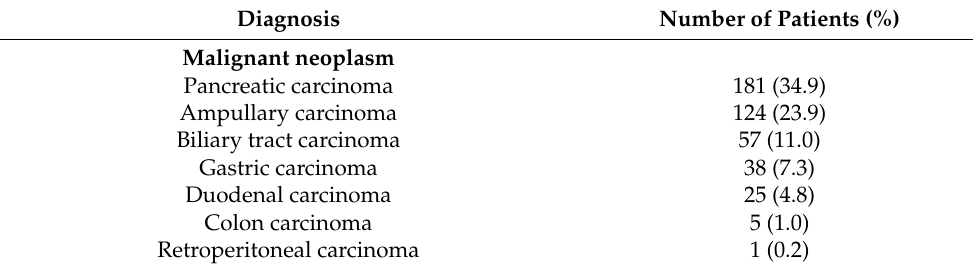
Table 1. Pathological diagnosis of resection lesions ( n =